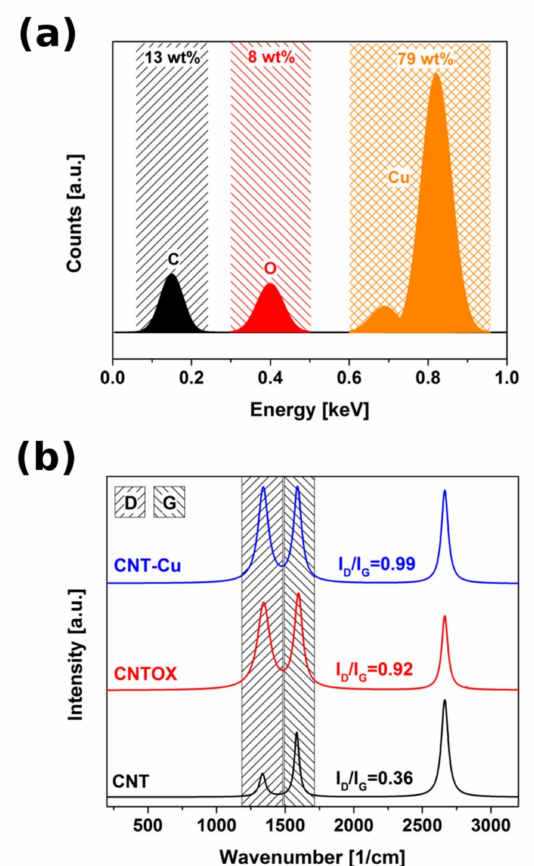
Figure 4. ( a ) EDX spectrum of a CNT-Cu composite ( b ) Raman spectra of the as-made CNT, CNTOX and CNT-Cu composite.